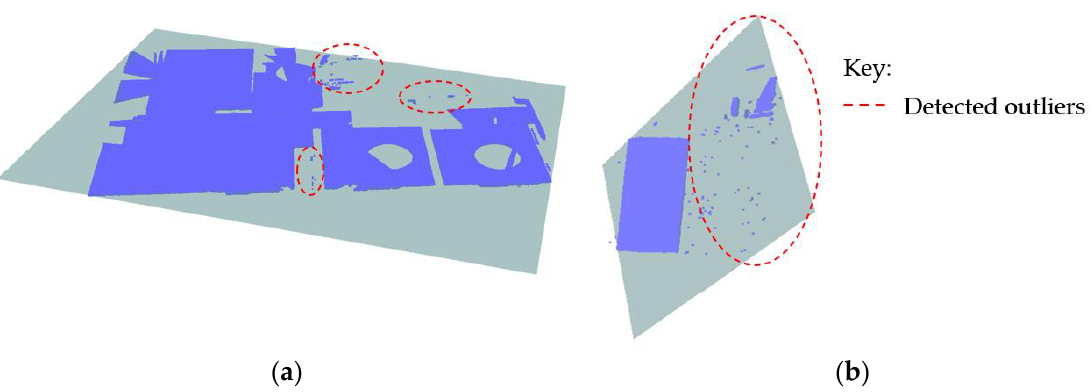
Figure 19. Point assignment to the spanned principal planes in searching for coplanar points and patches: ( a ) Outliers detected; ( b ) Surface patches and points from the clutter objects converge with spanned plane.